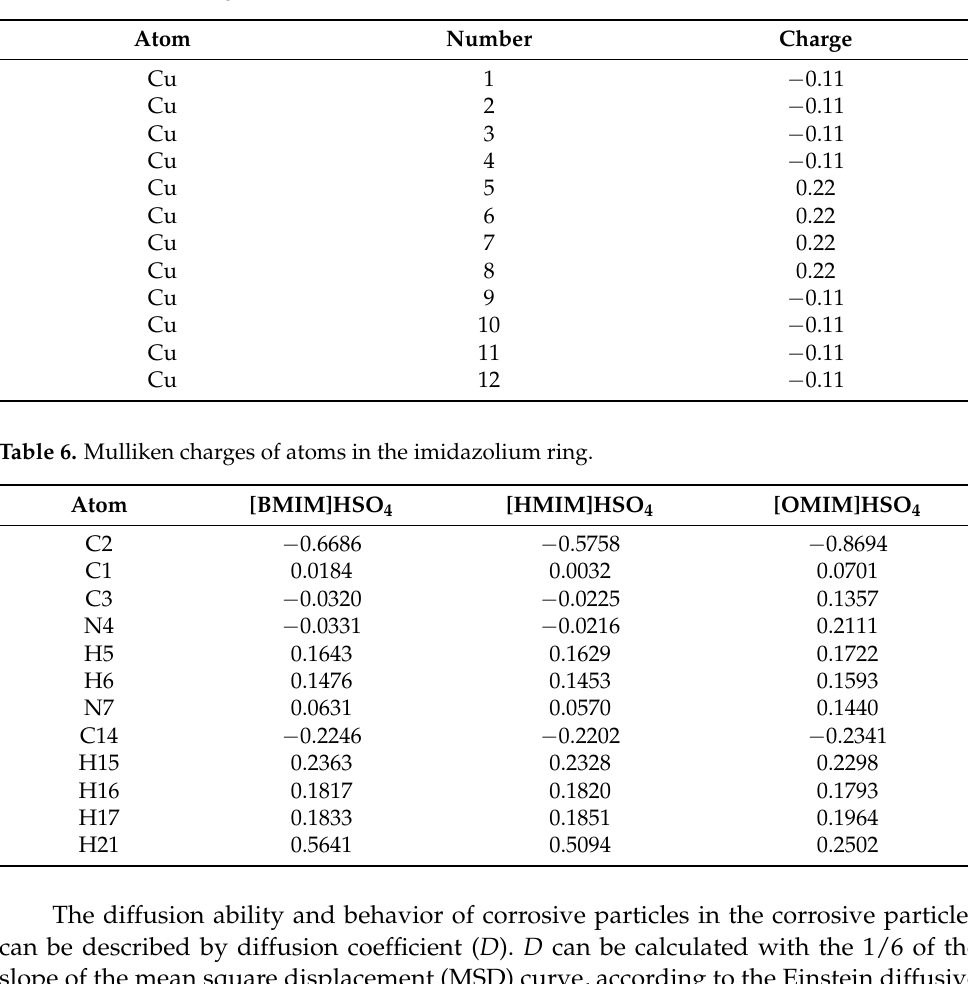
Table 5. Mulliken charges of the Cu(111) surface.